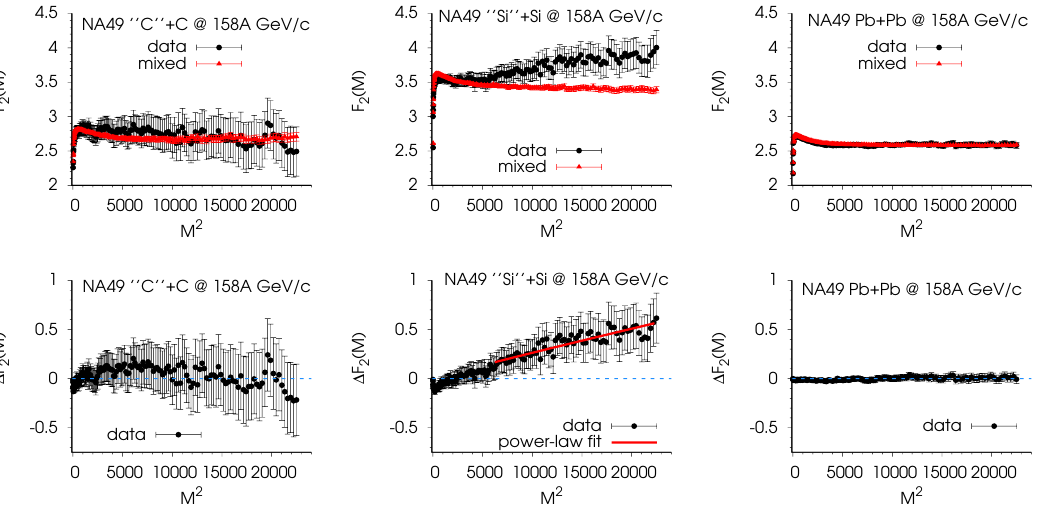
Figure 1. ( Top row ) F 2 ( M ) of original (filled circles) and mixed events (filled triangles) for NA49 “C” + C (left), “Si” + Si (middle), and Pb + Pb (right) most central collisions (12%, 12%, 10%, respectively) √ ( e ) ( M ) for the corresponding systems. “Si” + Si s NN = 17.3 GeV). ( Bottom row ) ∆ F at 158 A GeV/ c ( 2 ( e ) ( M ; C , φ ) = e C ( M 2 ) φ 2 , for M 2 > system (middle) is fitted with a power law, ∆ F 2 2